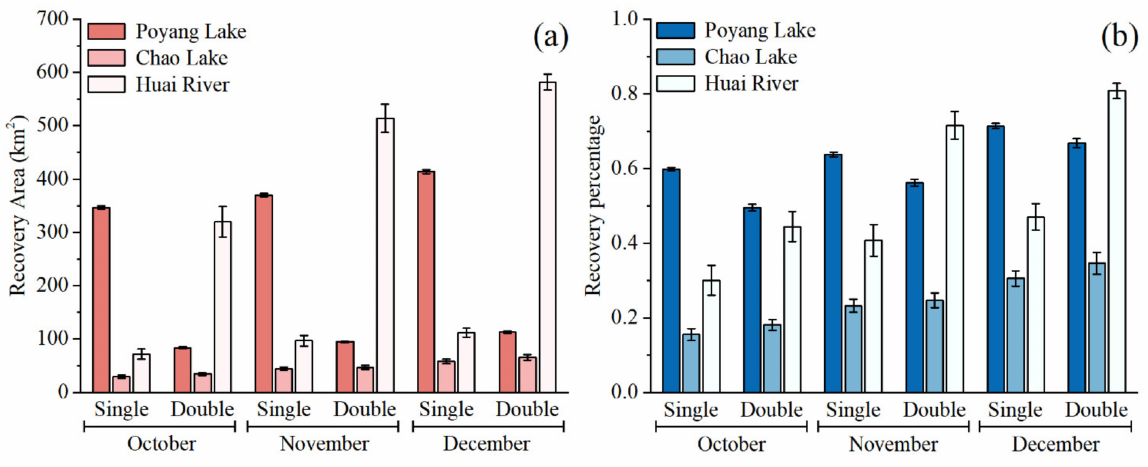
Figure 7. ( a ) Recovery area, and ( b ) recovery percentage statistics of the flood-affected croplands until late October, November, and December in the three study sites.